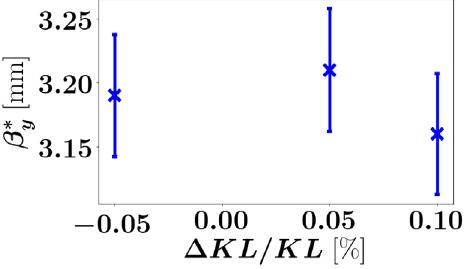
FIG. 18. Measured β (cid:1) y as a function of Δ KL for the K modulation measurements in HER. Error bars of 1.5% are